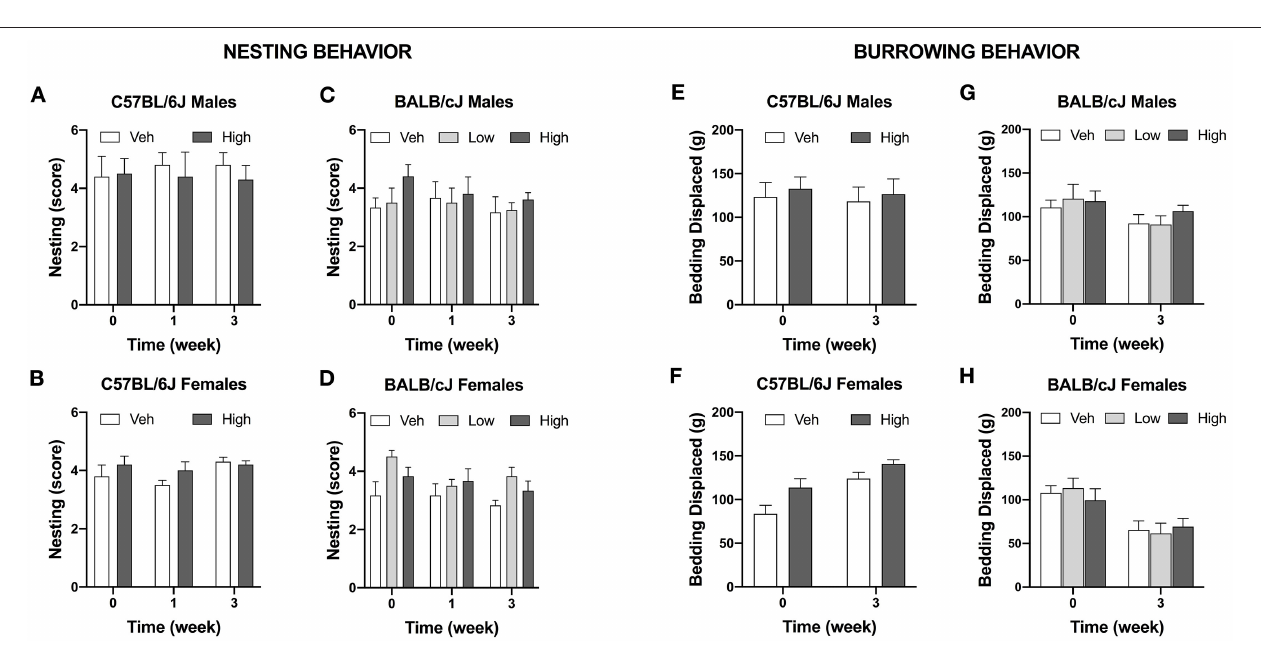
FIGURE 8 | Oxaliplatin has no effect on burrowing and nesting behavior in mice. Nest consolidation after 2h in C57BL/6J males ( n = 10/group) (A) , C57BL/6J females ( n = 10/group) (B) , BALB/cJ males ( n = 4–6/group) (C) , and BALB/cJ females ( n = 6/group) (D) . Burrowing assessment is depicted for C57BL/6J males ( n = 10/group) (E) , C57BL/6J females ( n = 10/group) (F) , BALB/cJ males ( n = 4–6/group) (G) , BALB/cJ females ( n = 6/group) (H) .